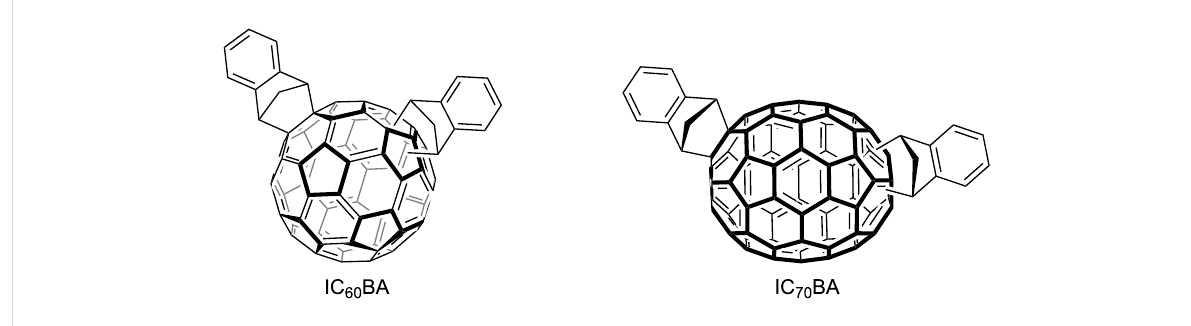
Figure 1: Molecular structure of IC 60 BA and IC 70 BA.